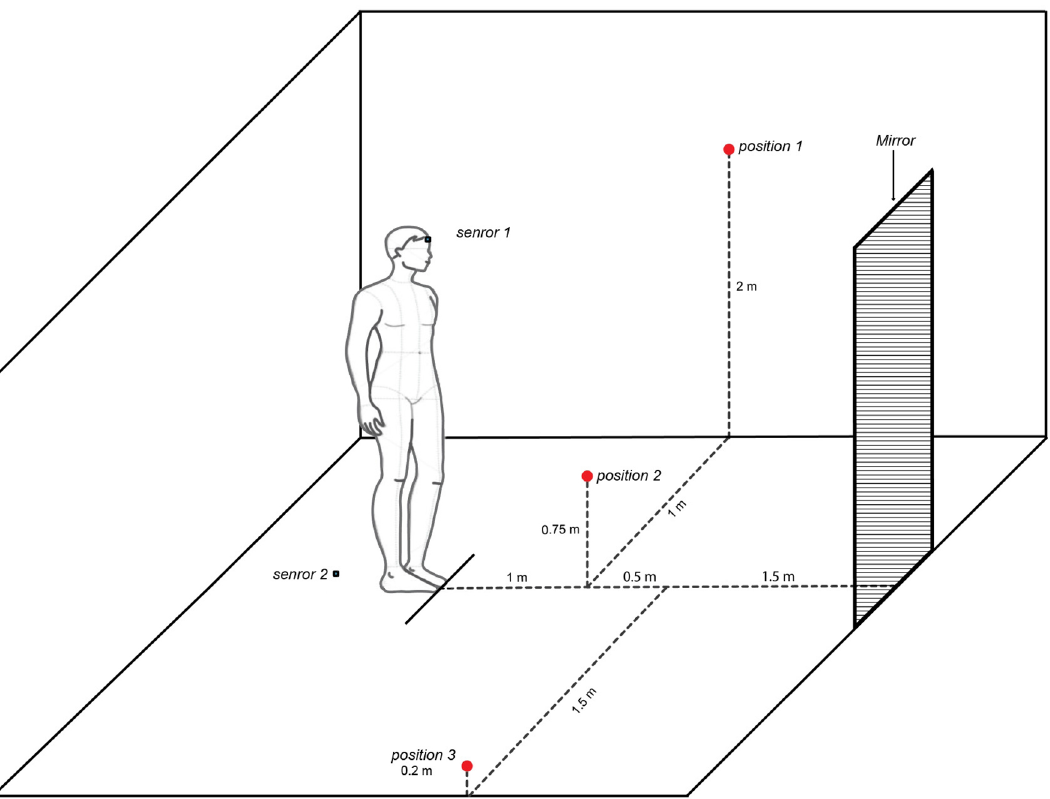
Figure 3. Representative image for the assessment of head posture and the reproducibility of the inertial measurement unit system. The participants were positioned in front of a mirror located 3 m in front of them. The first point was located 90 cm in front, 1 m to the left, and 2 m above their feet (position 1). The second point was 90 cm in front and 75 cm in height (position 2). The third point was located 1.50 m in front, 1.50 m to the right, and 20 cm in height (position